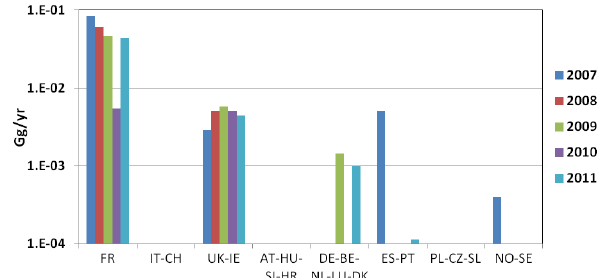
Figure 3. European atmospheric emissions of MCF as reported by E-PRTR. FR, France; UK, United Kingdom; IE, Republic of Ire- land; DE, Germany; BE, Belgium; NL, the Netherlands; LU, Lux- embourg; DK, Denmark; ES, Spain; PT, Portugal; NO, Norway; SE,